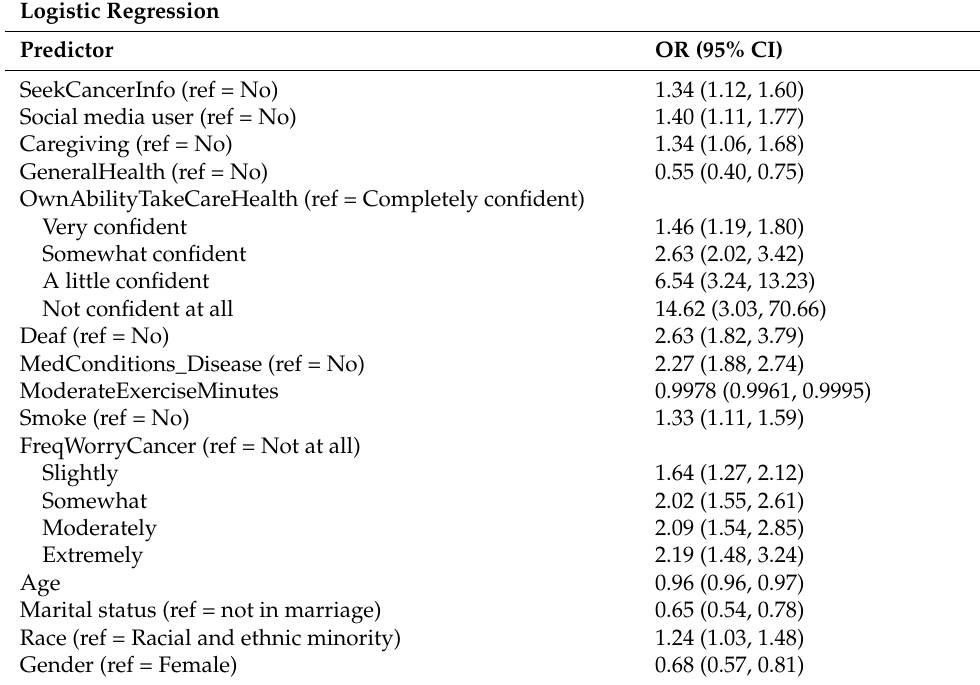
Table 2. Predictors of psychological distress identified using a logistic regression